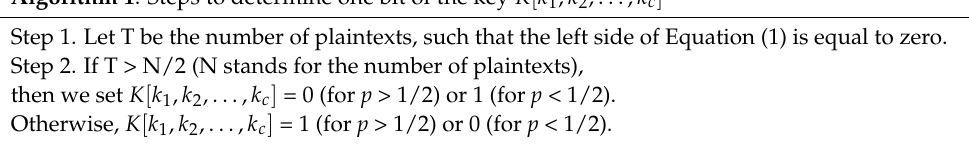
Algorithm 1 : Steps to determine one bit of the key K [ k 1 , k 2 , . . . , k c